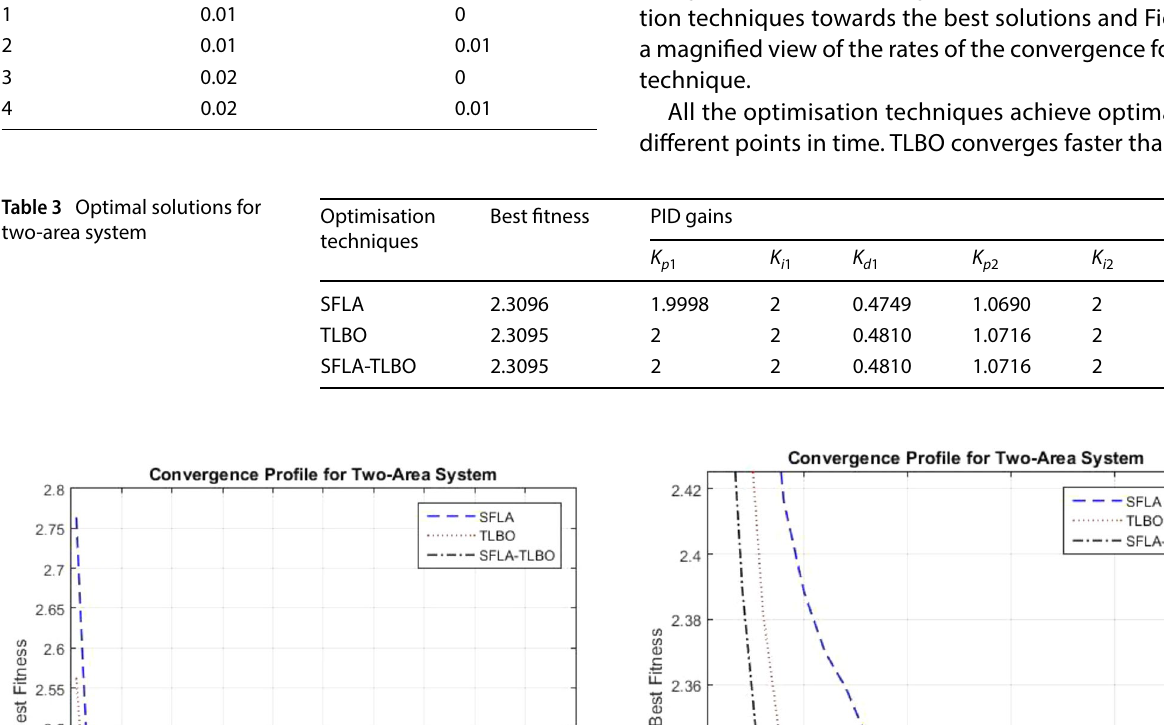
Table 2 Loading conditions for non-linear two-area system Loading conditions